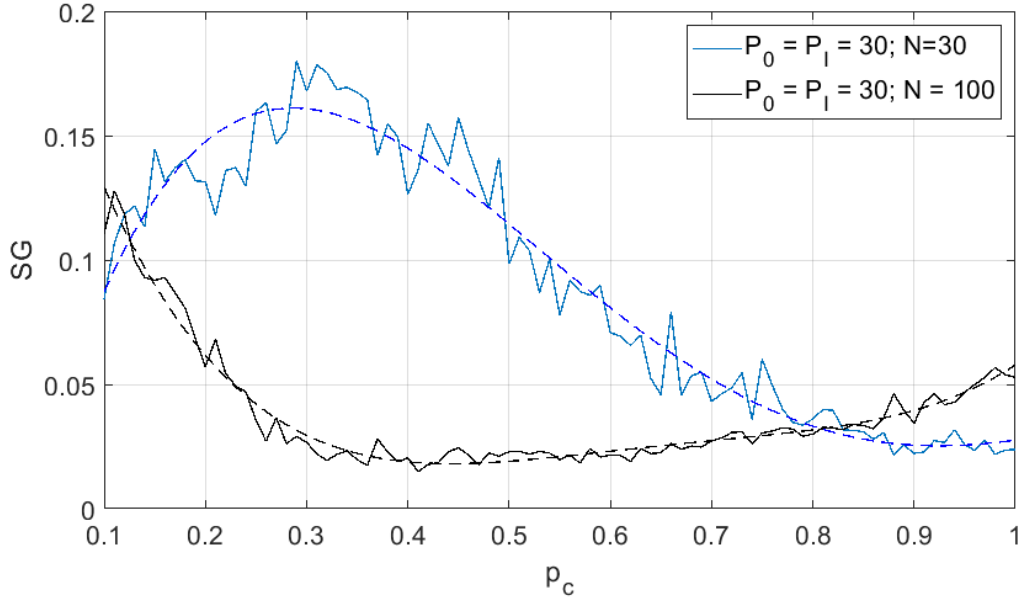
Figure 5. Second largest cluster size as function of node operation probability (different number of nodes). Dashed lines are a fourth-degree polynomial approximation.